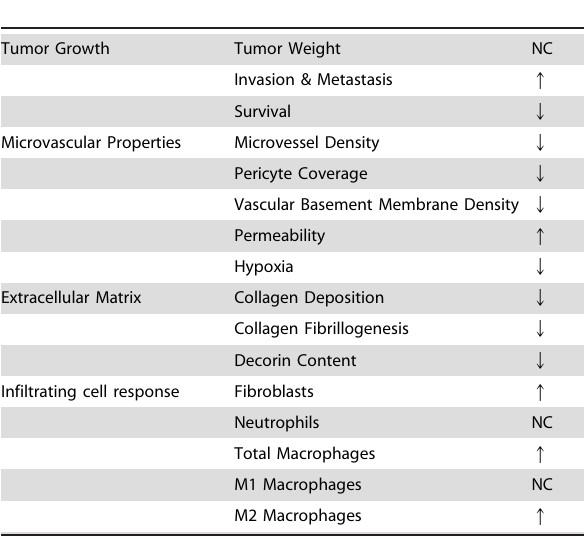
Table summarizing the tumor-associated effects previously analyzed in SPARC 2 / 2 ( SP 2 / 2 ) mice bearing orthotopic Pan02 tumors. Arrows indicate whether SPARC 2 / 2 mice displayed an increase ( q ) or decrease ( Q ) compared to SPARC + / + mice. NC, no change.